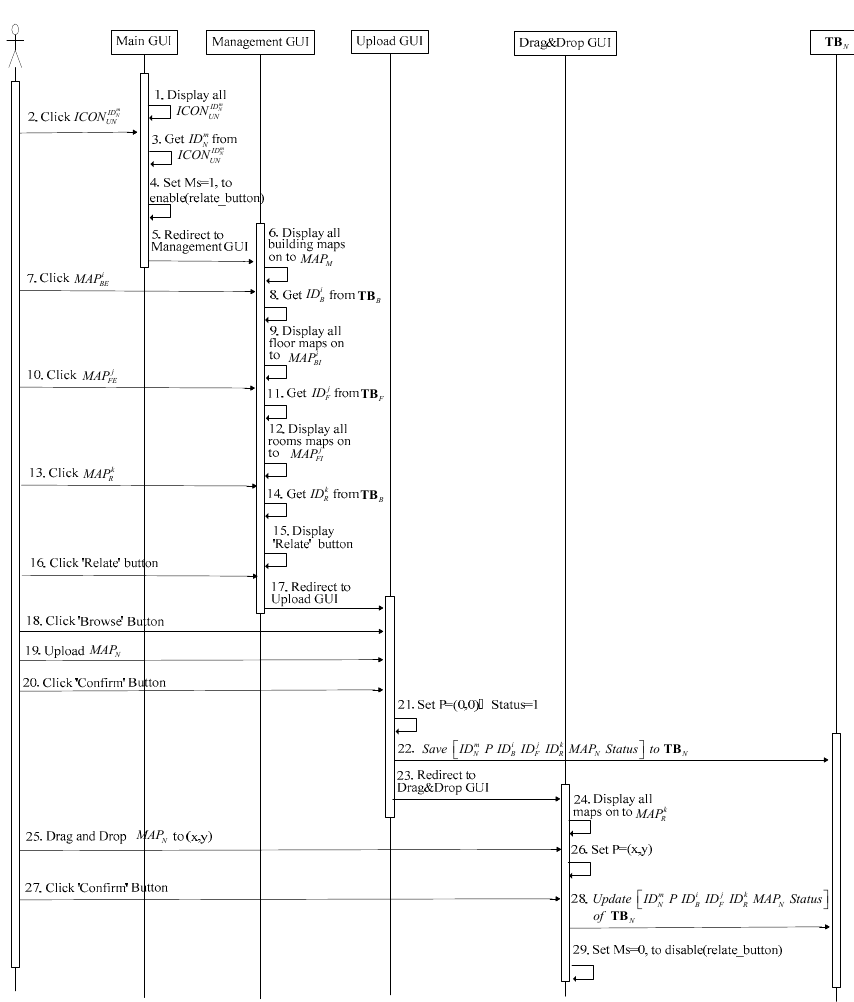
Figure 5. Procedure to relate node m to room k on floor j in building i